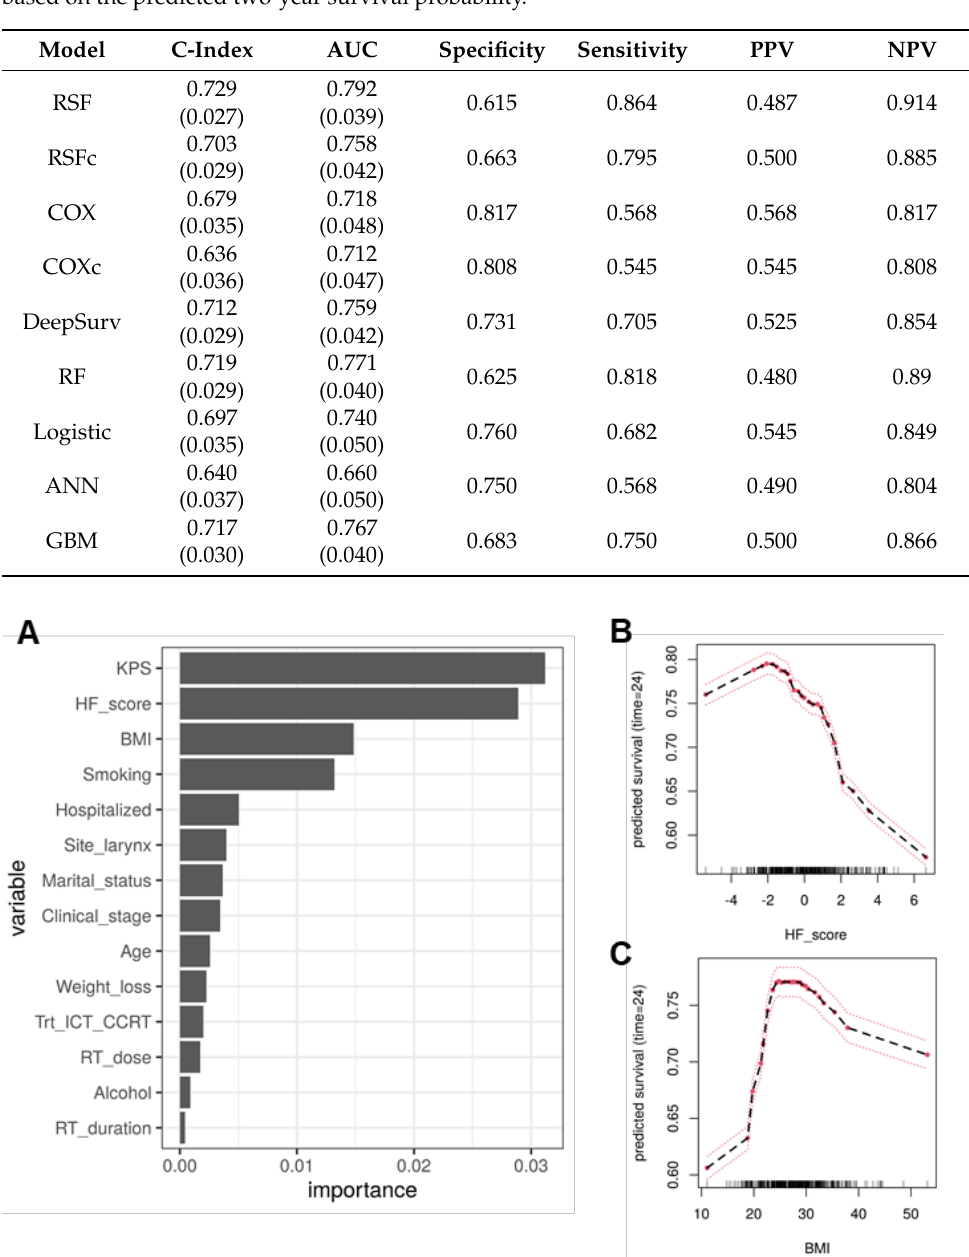
Figure 3. ( A ) Variable importance for the top predictors of the final model. The HF score is among the top ranked variable. ( B ) The partial dependence plot of the BMI with the two-year survival rate as outcome. ( C ) The partial dependence plot of the HF score with the two-year survival rate as outcome.